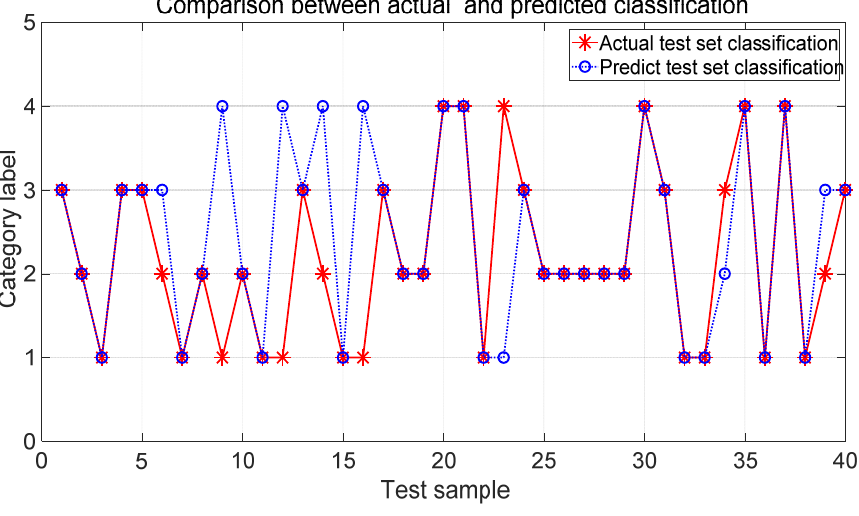
Figure 10. Classification with BP neural network.